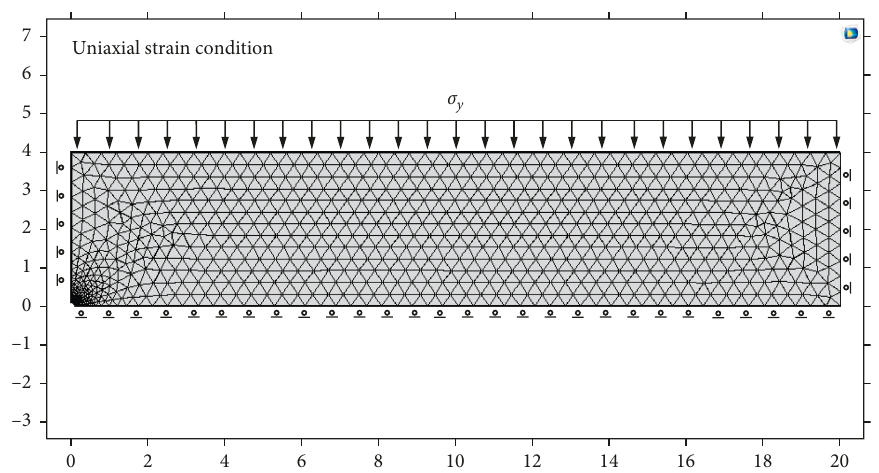
Figure 10: Illustration of the numerical model under uniaxial strain condition.